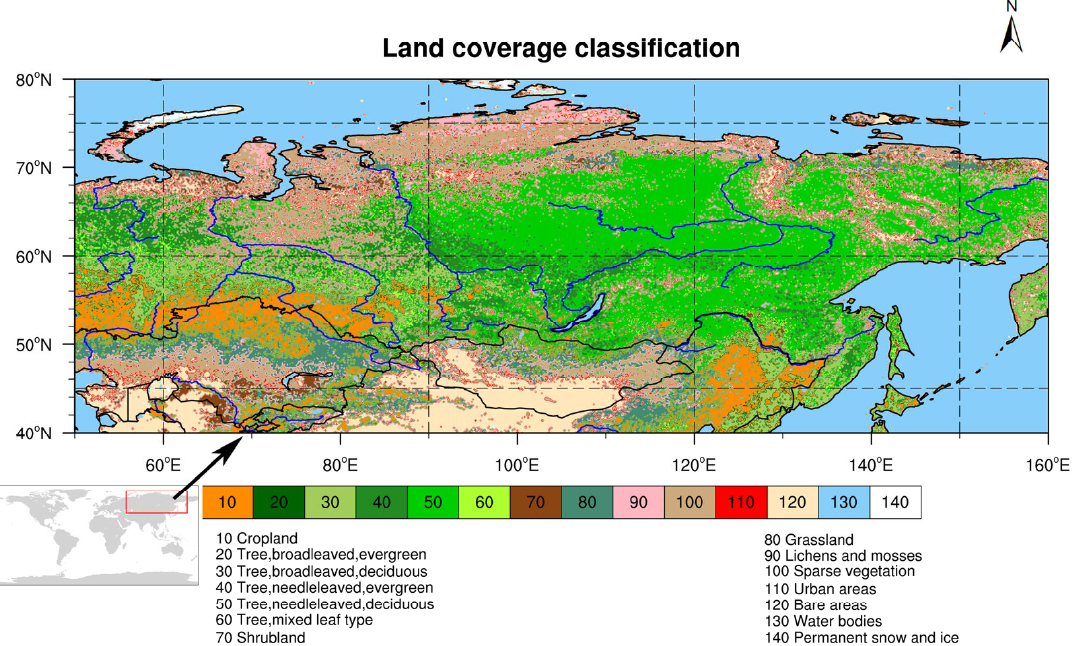
Figure 1. Distribution of vegetation types in 2016. The reclassification is based on the United Nations Food and Agriculture Organization’s (UN FAO) Land Cover Classification System (LCCS).